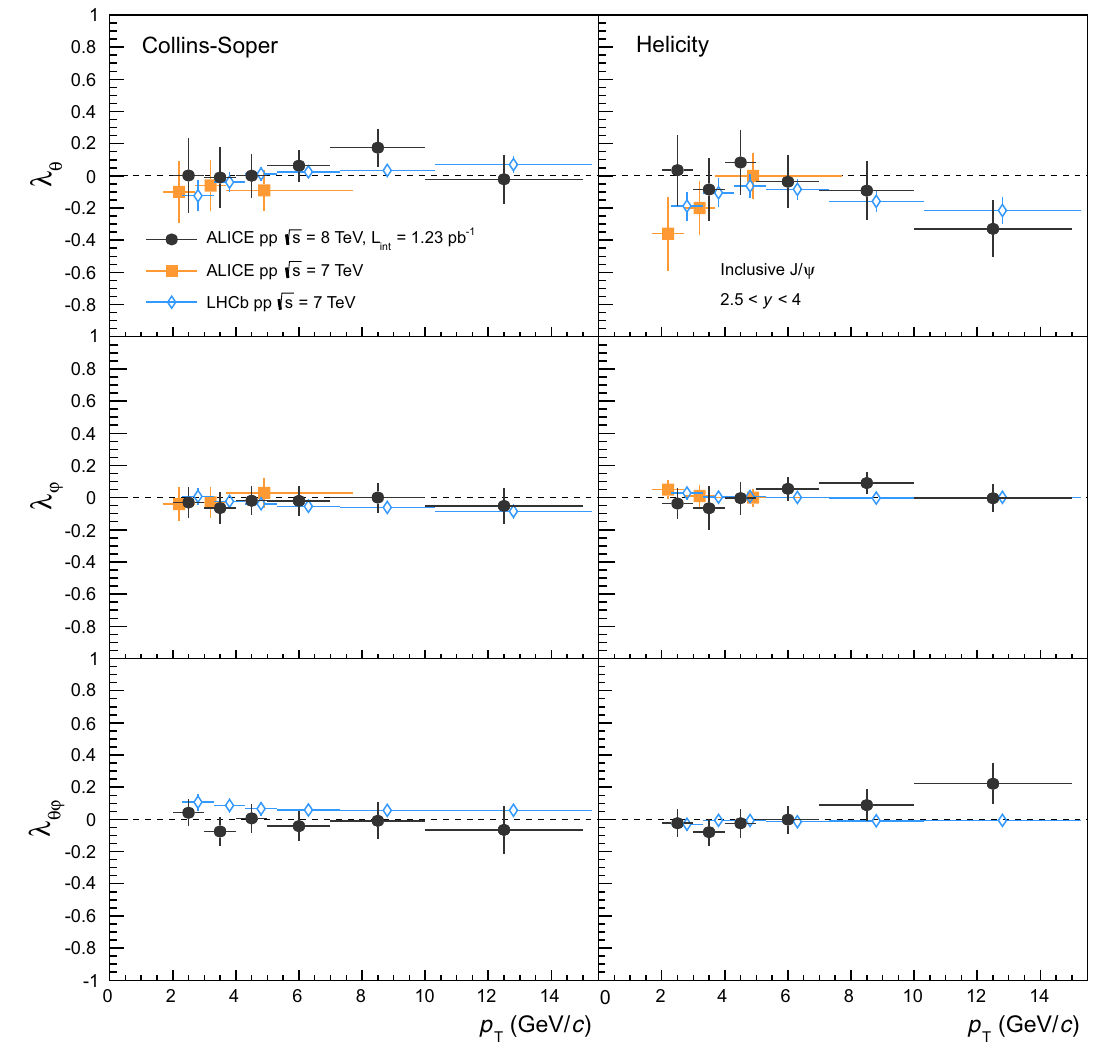
Fig. 3 ALICE inclusive J/ ψ polarization parameters in pp collisions √ s = 8 TeV (black points) compared with ALICE [13] inclusive J/ ψ at (orange squares, shifted horizontally by − 0 . 3 GeV / c ) and LHCb [14] prompt J/ ψ (blue open diamonds, shifted horizontally by + 0 . 3 GeV / c )